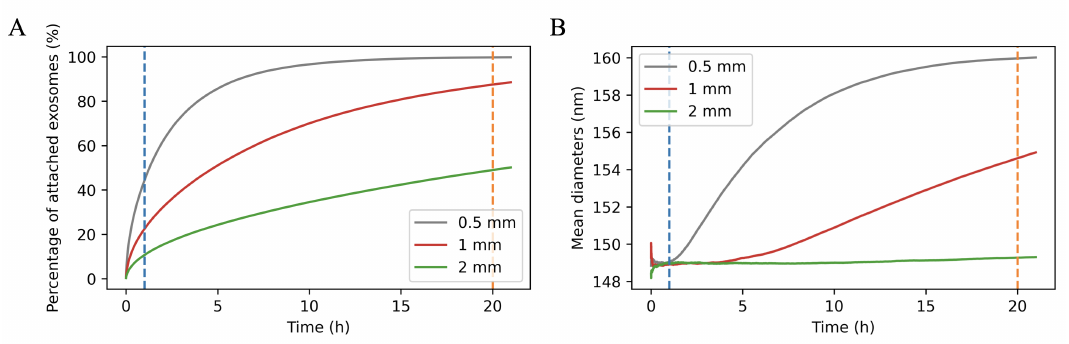
Figure 4. Characteristics of the nanovesicles attached to the substrate as a function of the time from applying the sample on mica, based on the Monte Carlo simulation: ( A ) percentage of attached vesicles; ( B ) mean hydrodynamic diameter of attached vesicles.